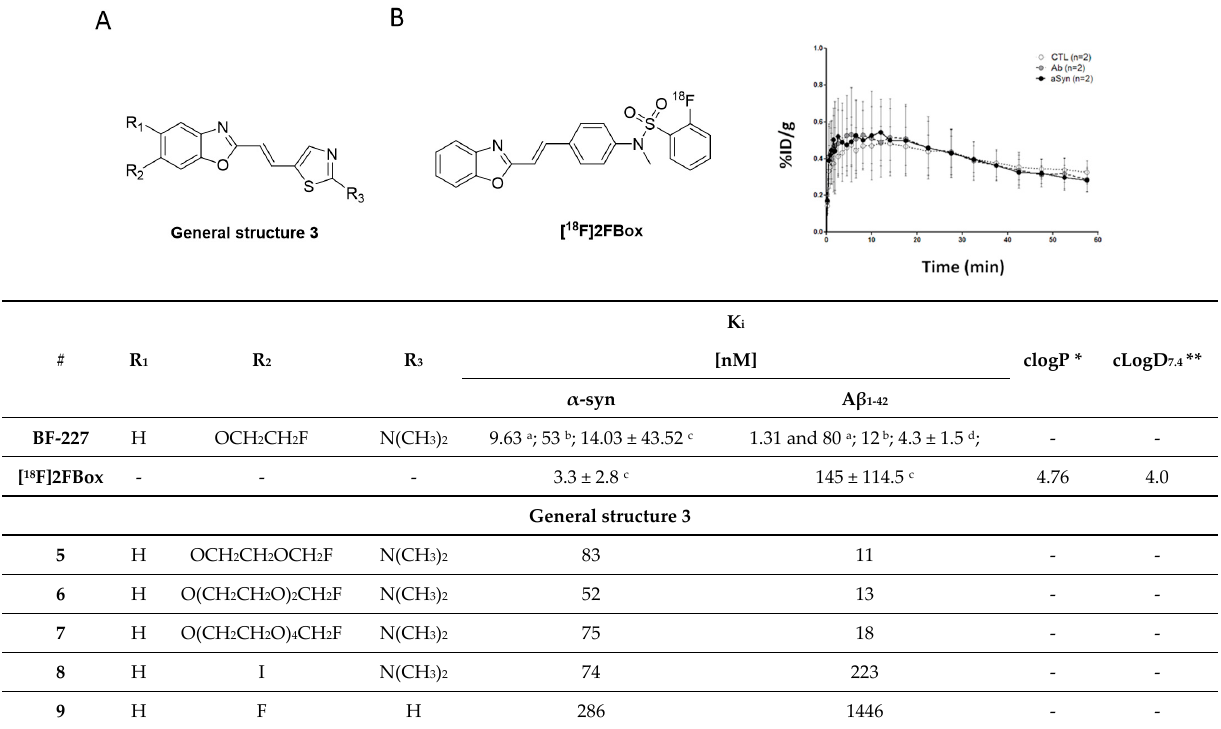
Figure 10. ( A ) General structure of BF-227-like compounds with binding properties specified in table. Affinities were determined for α -syn and A β 1–42 fibrils. Binding affinities were determined by several techniques: a K d values identified with Scatchard analysis [99,103]. b In vitro saturation assay using synthetic α -syn and A β 1–42 fibrils [67]. c In vitro saturation binding assay [67]. d In vitro binding assays (K i ) determined for A β 1–42 fibril in competitive binding assay using [ 125 I]BF- 180 [98]. * clogP values were calculated by BioByte. ** clogD 7.4 values calculated by ACD/Percepta. ( B ) The chemical structure of [ 18 F]2FBox with the TAC from small-animal PET imaging of fibril-injected rats (controls were taken from the striata regions) (reprinted with permission from [67]. Copyright 2018 American Chemical